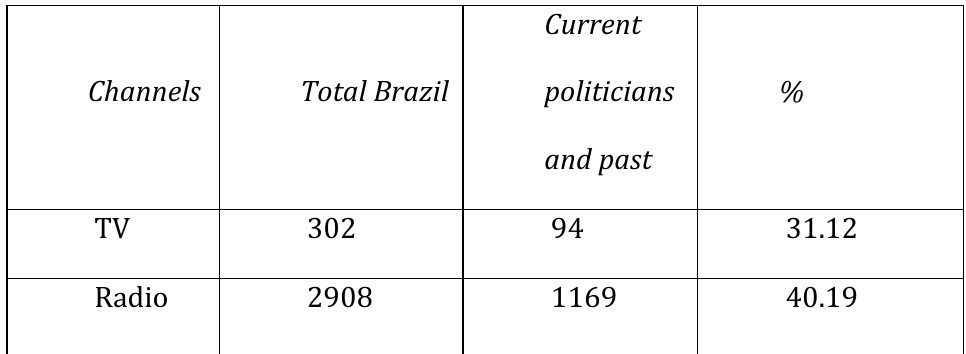
Table 1 Radio and TV stations controlled by politicians in Brazil